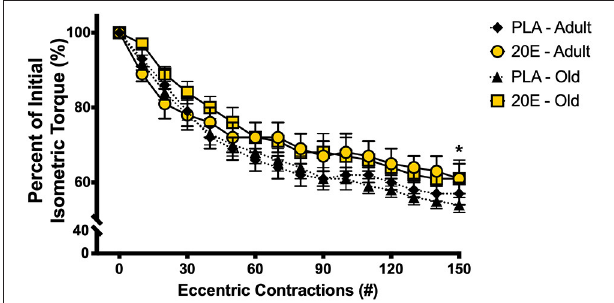
FIGURE 1 | Percent of initial isometric torque during the 150 eccentric contraction-induced muscle damage protocol. Maximal tetanic isometric torque of the anterior crural muscles was measured after every 10th eccentric contraction of the damage protocol in adult and old mice. There was a significant 40–50% decline in isometric torque after the 150-eccentric contraction muscle damage protocol, regardless of age or treatment condition. Values represent mean ± SEM. PLA, placebo; 20E, 20-hydroxyecdysone. * significantly different than initial; p <